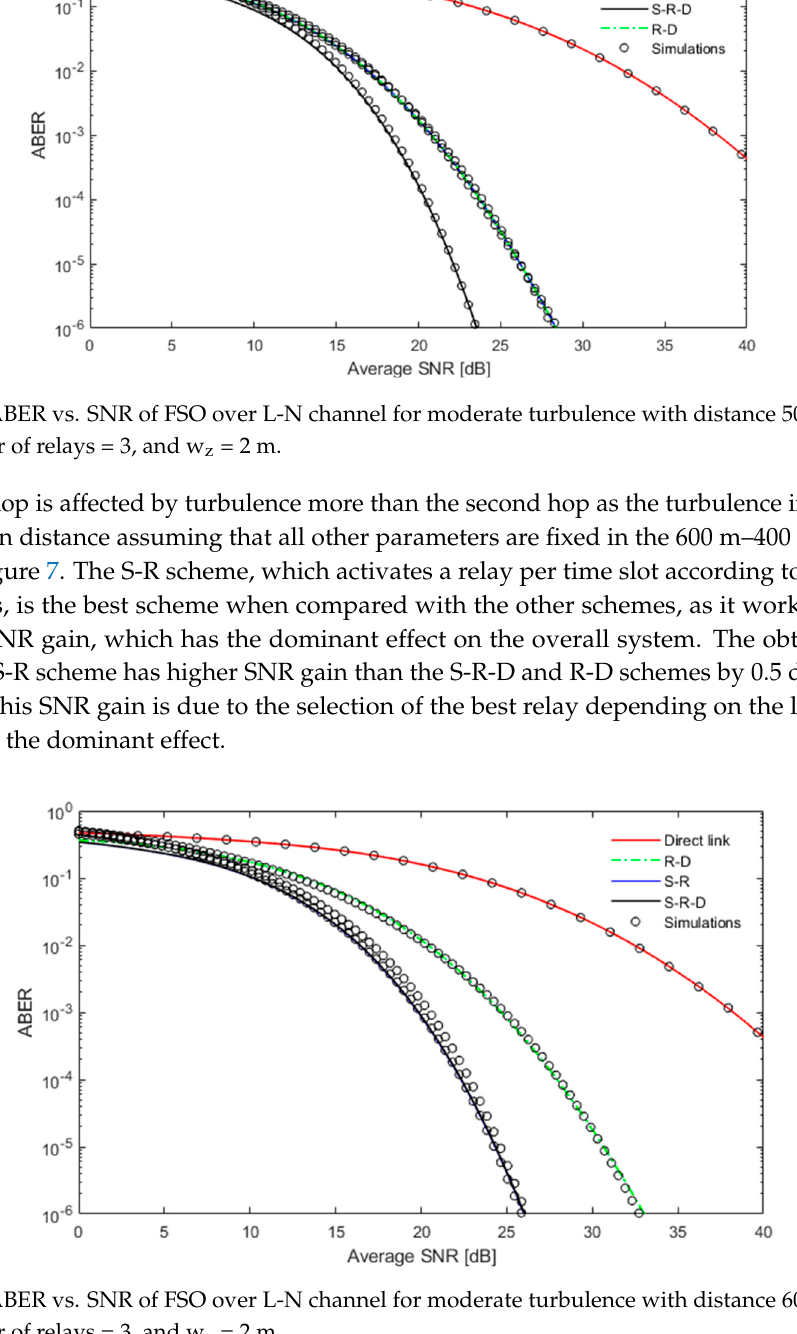
the number of relays = 3, and w z = 2m.